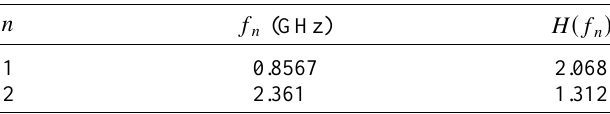
TABLE II. Response of the q - U rf measurement line at the operating frequencies.